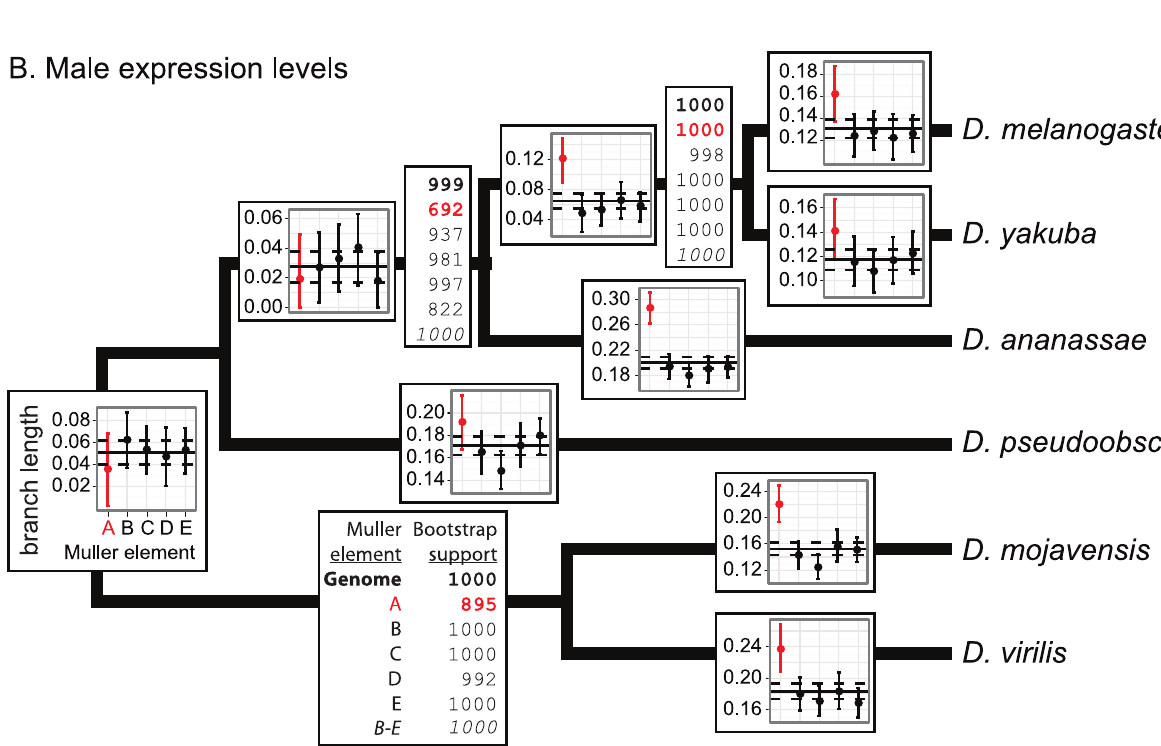
PLOS Genetics | www.plosgenetics.org